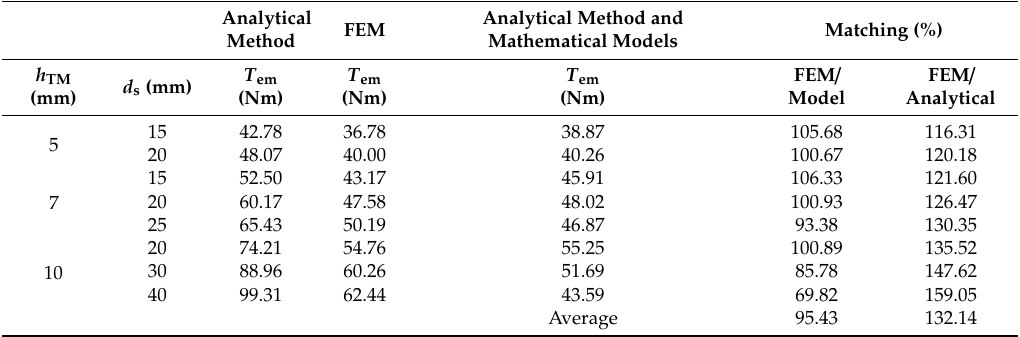
Table 6. Results of the design of 20-pole AFPMSM using FEM and comparison of the results of all three